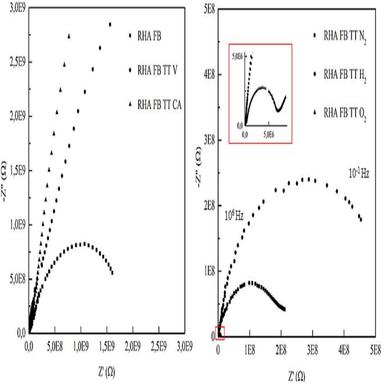
Nyquist diagrams of heat treatments derived from RHA FB.